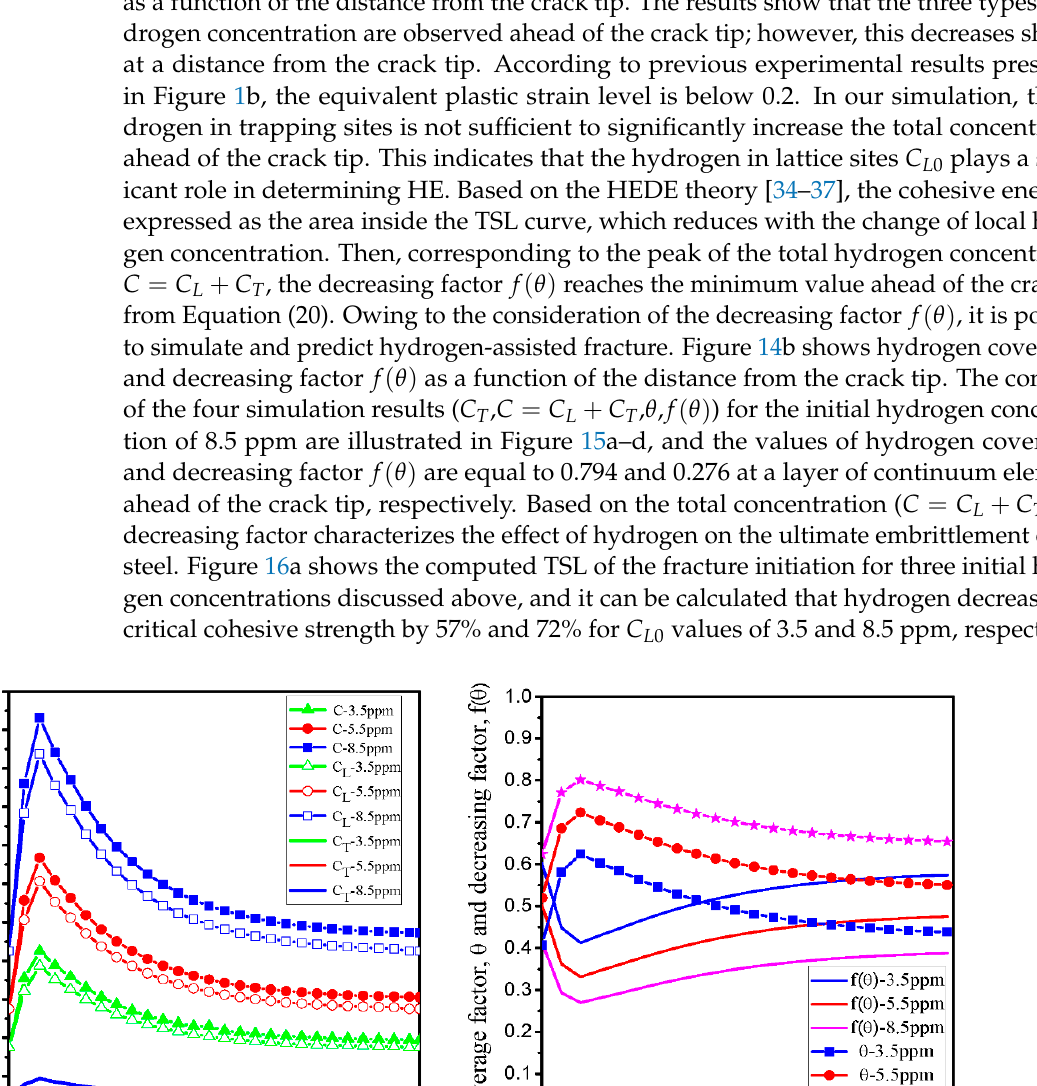
C C C = + ) as a function of distance from the crack tip L T ( ) f θ as a function of dis-